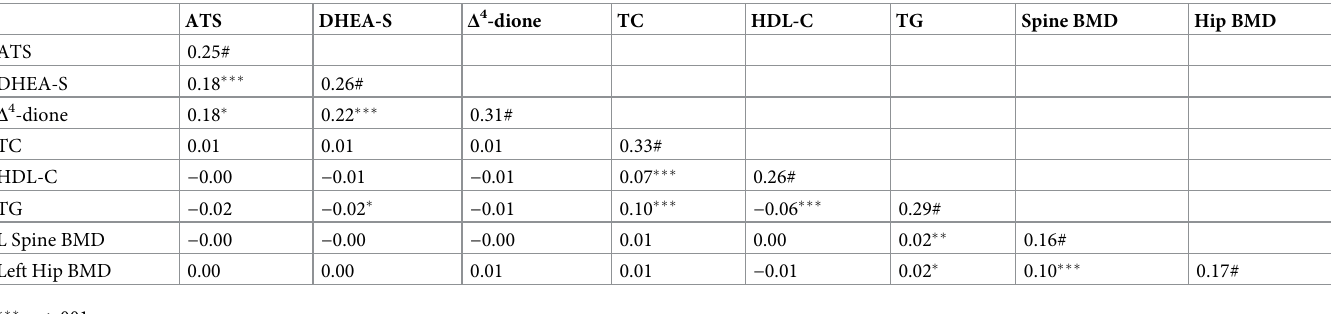
Table 4. Phenotypically standardized non-shared environmental variance components.